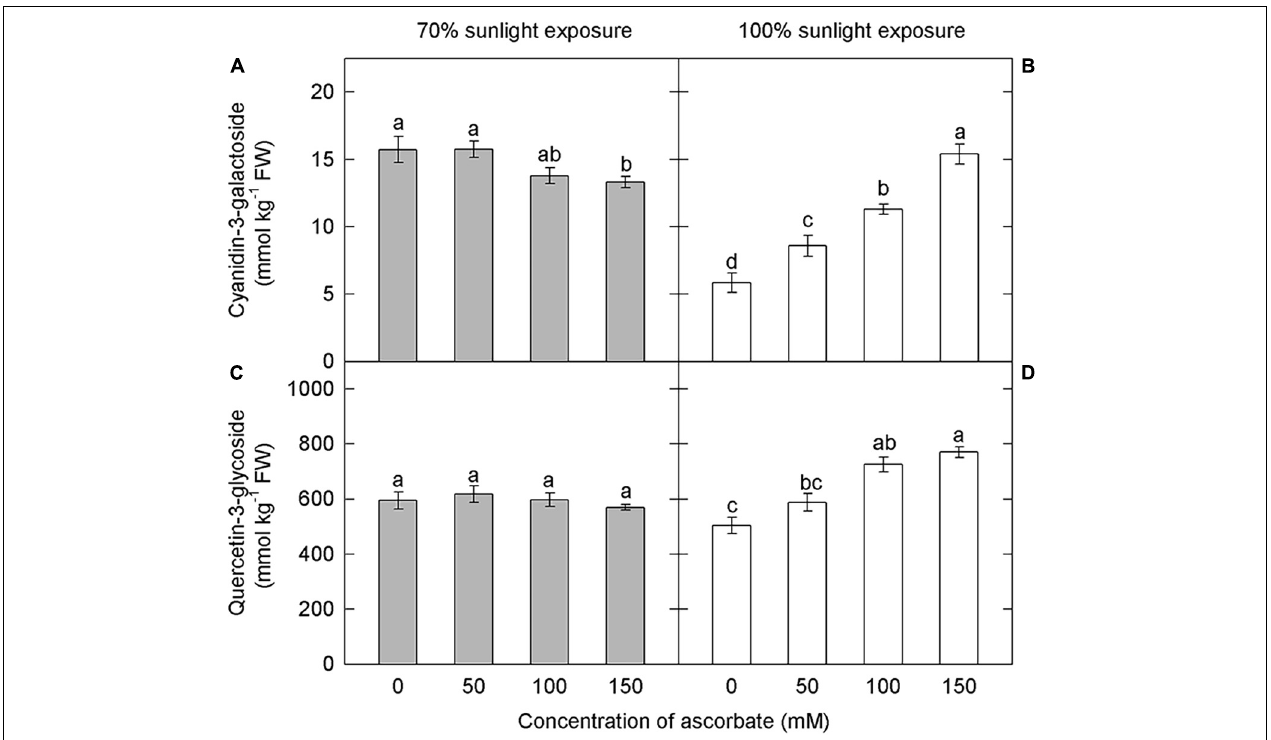
FIGURE 8 | Effect of exogenous ascorbate on the concentration of cyanidin-3-galactoside and quercetin-3-glycoside in the peel of “Fuji” apple fruits. Concentrations of cyanidin-3-galactoside (A) , quercetin-3-glycoside (C) in the peel of “Fuji” apples soaked in ascorbic acid of 0, 50, 100, and 150 mM and 70% sunlight intensity. Concentrations of cyanidin-3-galactoside (B) , quercetin-3-glycoside (D) in the peel of “Fuji” apples soaked in ascorbic acid of 0, 50, 100, and 150 mM and 100% sunlight intensity.